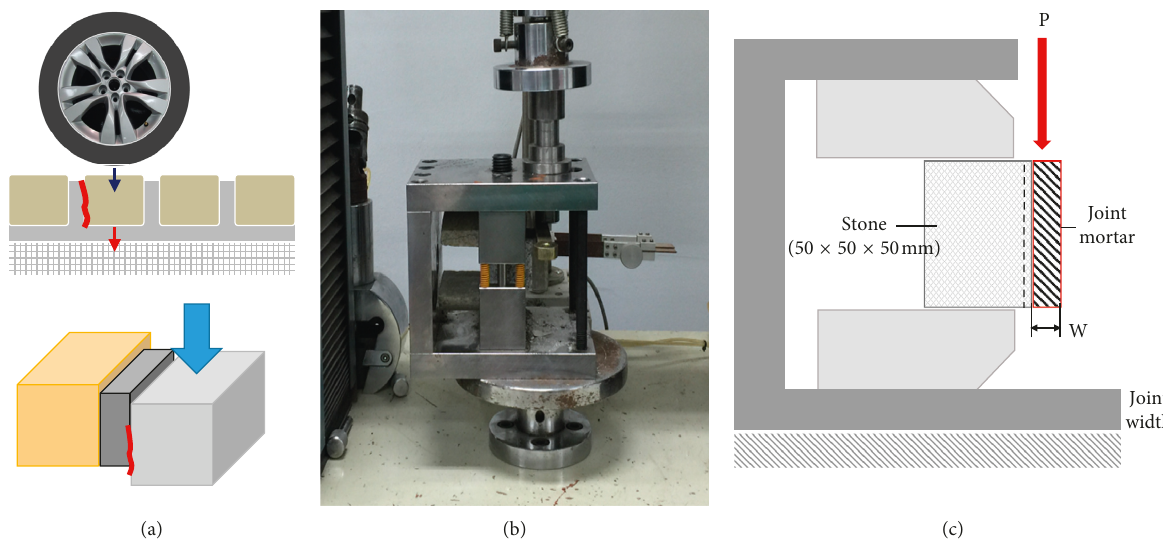
Figure 4: Shear strength of joint mortar. (a) Loss of shear strength. (b) Testing apparatus. (c) Shear strength test